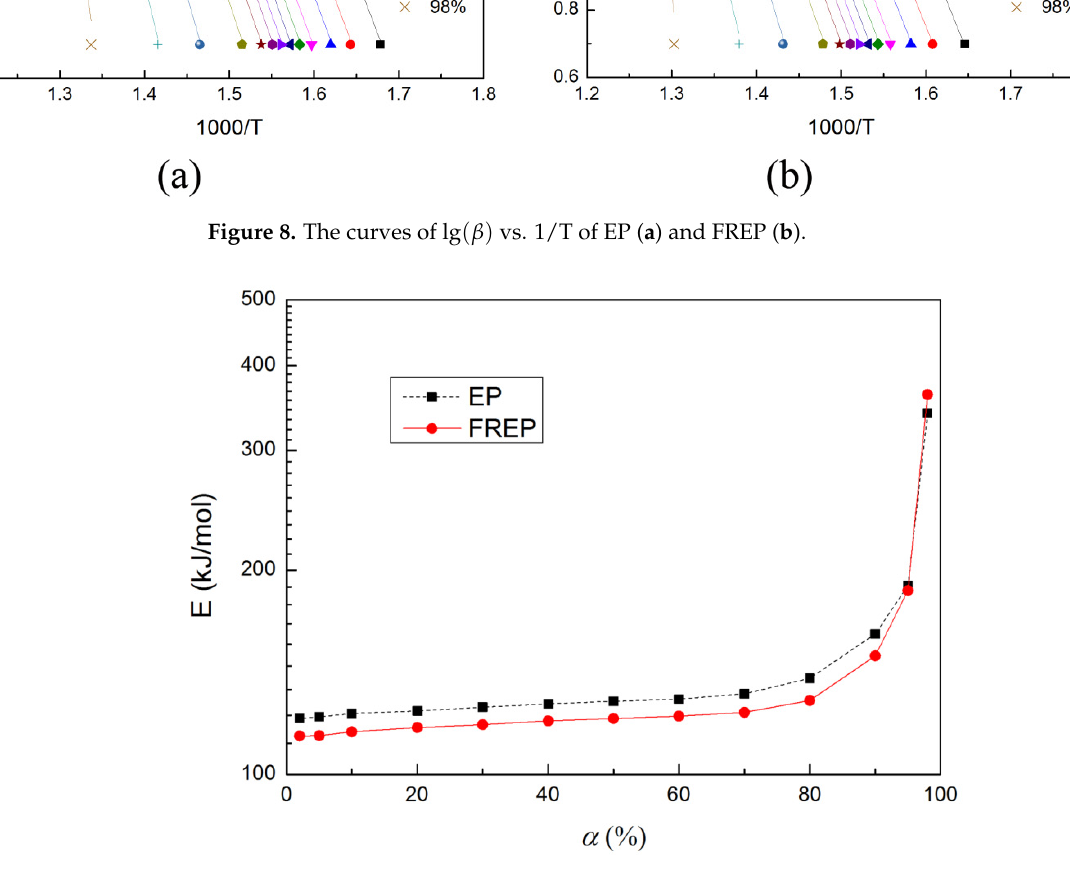
Figure 9. Activation energy curves of EP and FREP by Flynn-Wall-Ozawa method.